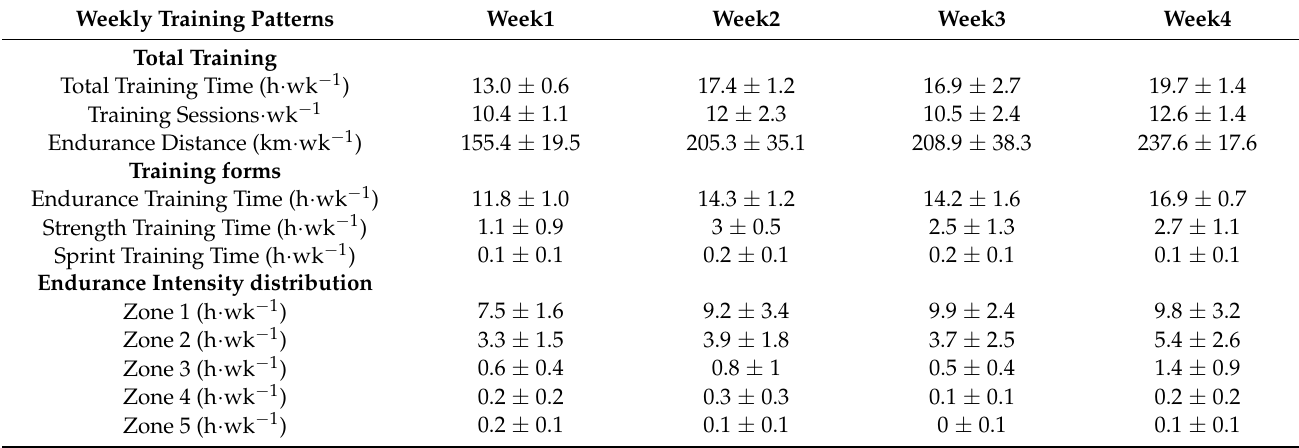
Table 2. Training Characteristics of 4 weeks Moderate Altitude